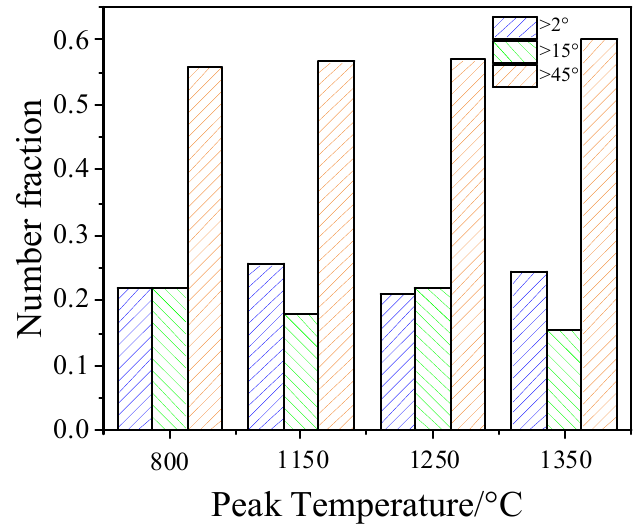
Figure 12. Misorientation angle distribution at different peak temperatures.